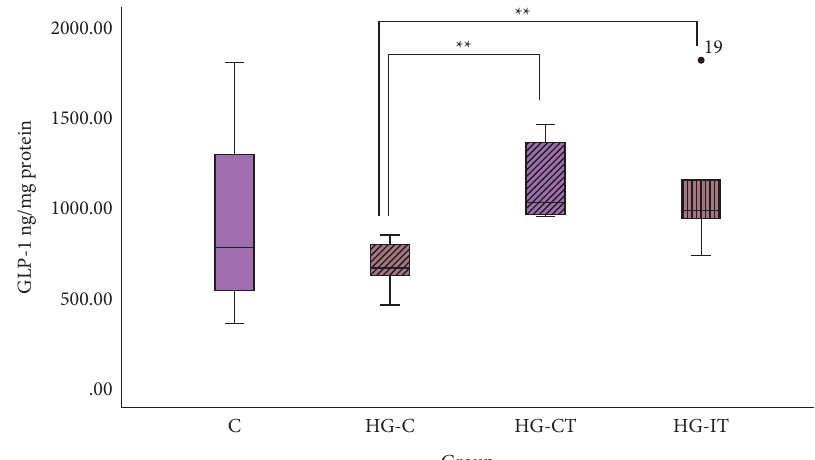
Figure 2: GLP-1 concentration within each group. c: control group; HG-C: hyperglycemic control group; HG-CT: hyperglycemic rats that did moderate-intensity continuous training (MICT); HG-IT: hyperglycemic rats that did high-intensity interval training (HIIT). Te error bars represent the standard deviation of measurements. ∗∗ p < 0 . 01